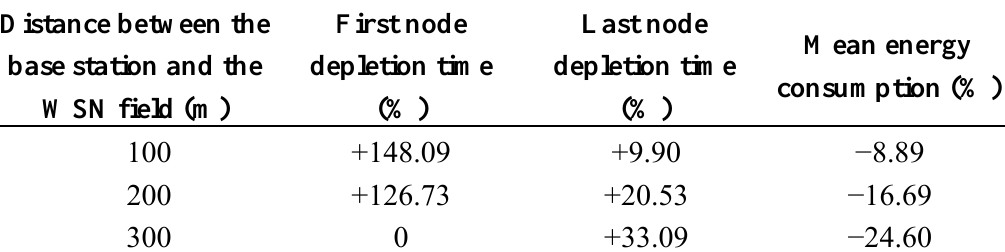
Table 2. Percentage of change in WSN performance by the use of SHPER opposed to TEEN over the distance of the base station from the sensor field when the initial node energy is set to 0.5 J.